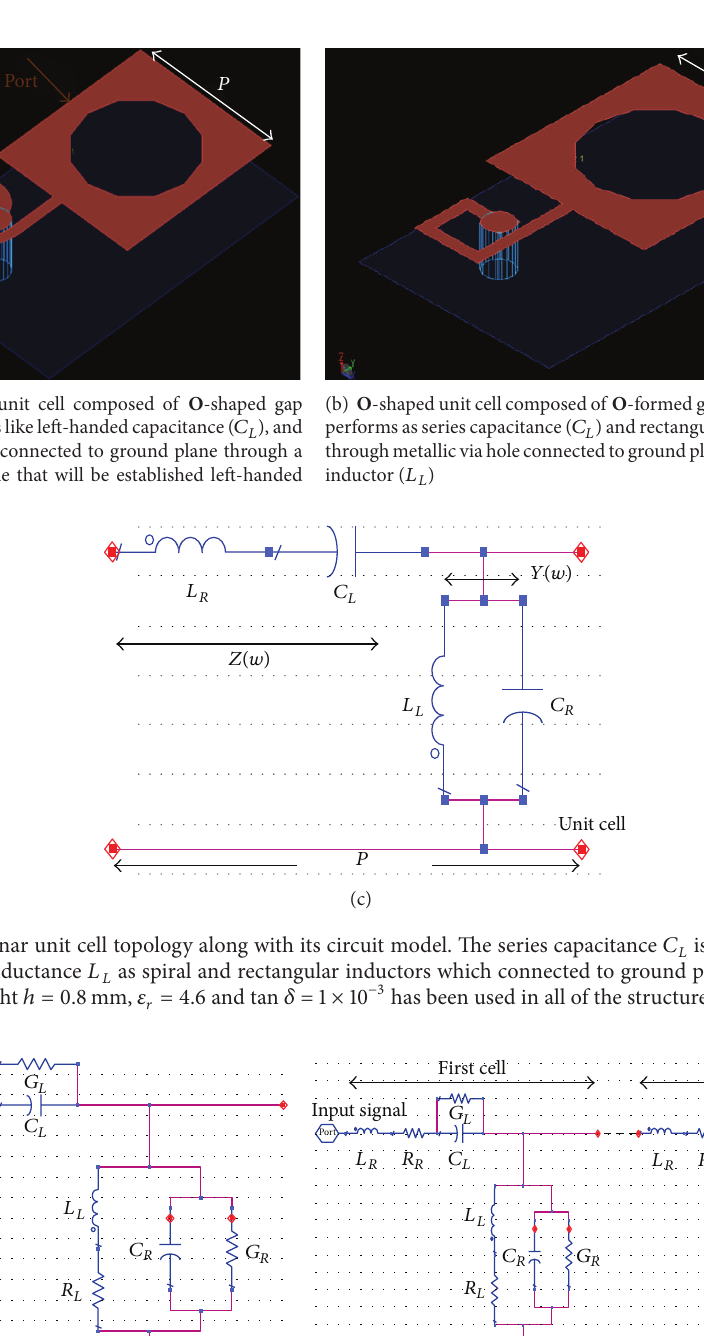
wavelength. Planar patch antennas are very attractive from the point of fabrication and system integration despite being limited in size to a half of the substrate wavelength because of their resonant nature. The principle of reactive loading of patch antennas to change their pattern, impedance, resonant frequency, and so forth is known for a long time